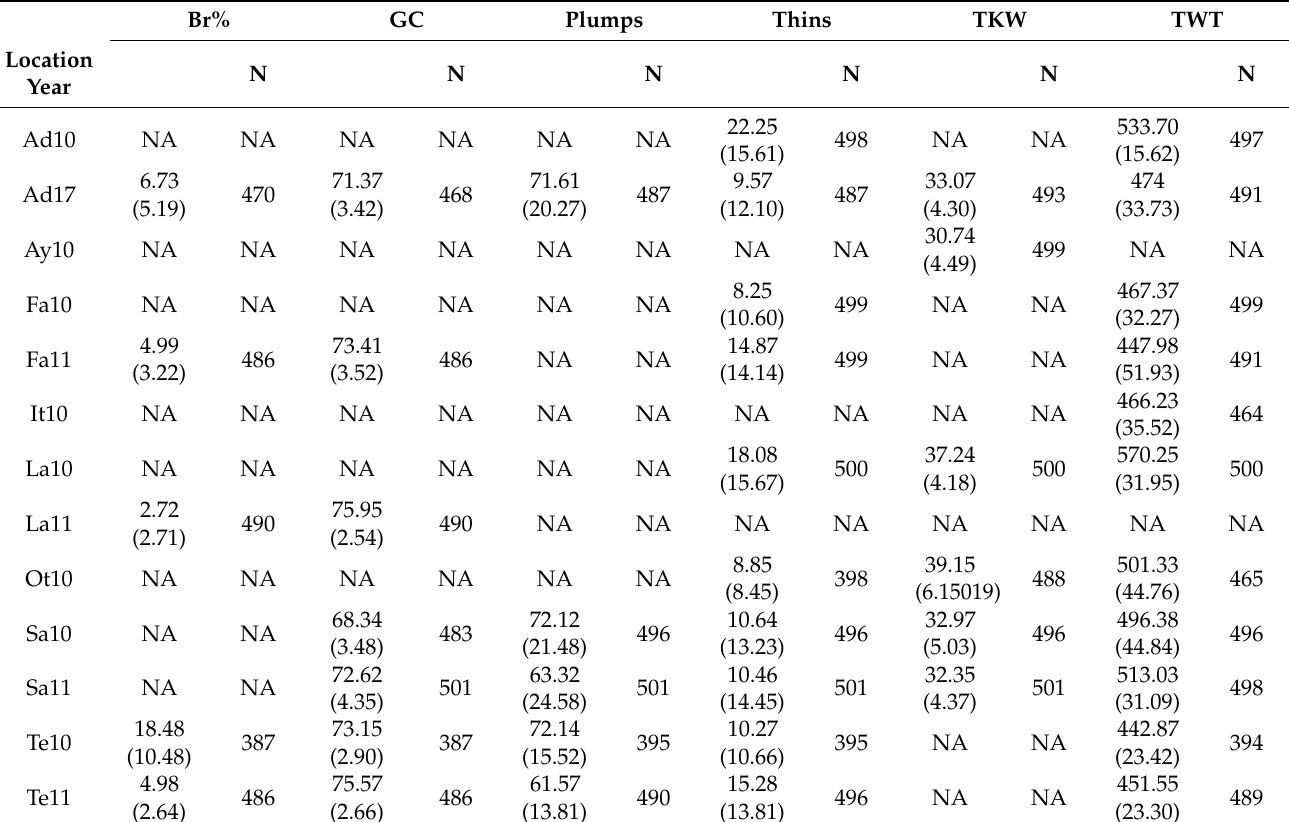
Table 1. Mean (Standard deviation) and number of observations (N) of percent broken groats (Br%), groat content (GC), percent plump kernels (Plumps), percent thin kernels (Thins), thousand kernel weight (TKW) and test weight (TWT) for grain from location years used in this